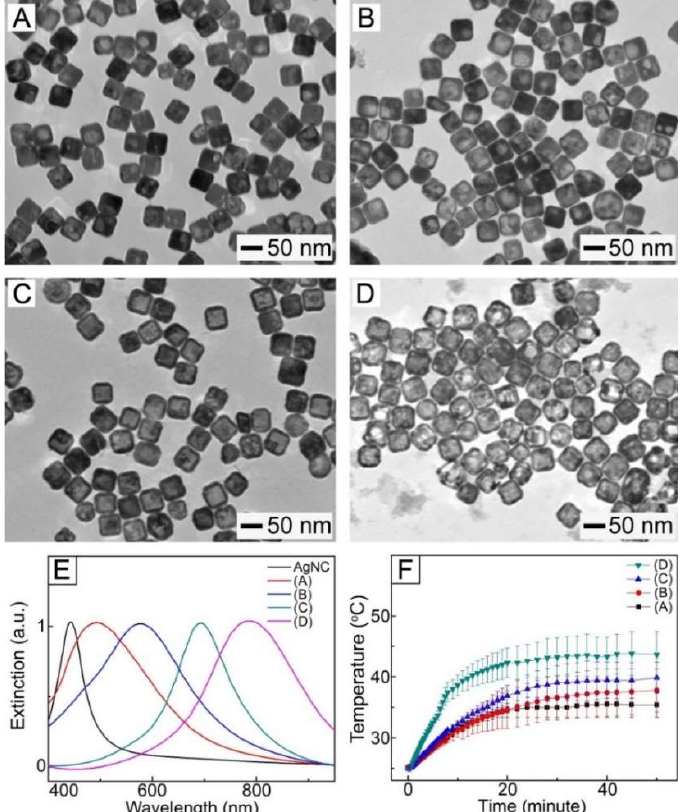
Figure 1. ( A – D ) TEM images of the particles obtained after the reaction of AgNCs with different amounts of HAuCl 4 solution: ( A ) 0.06, ( B ) 0.08, ( C ) 0.15 and ( D ) 0.2 mL. ( E ) UV–VIS–NIR extinction spectra for the particles of ( A – D ) in DI water. ( E ) UV–VIS–NIR extinction spectra for the particles of ( A – D ) and AgNCs in DI water. ( F ) Change in temperature for the particles of ( A – D ) in DI water with a concentration of 0.1 mg/mL under NIR light irradiation (1 W/cm 2 , 808 nm).